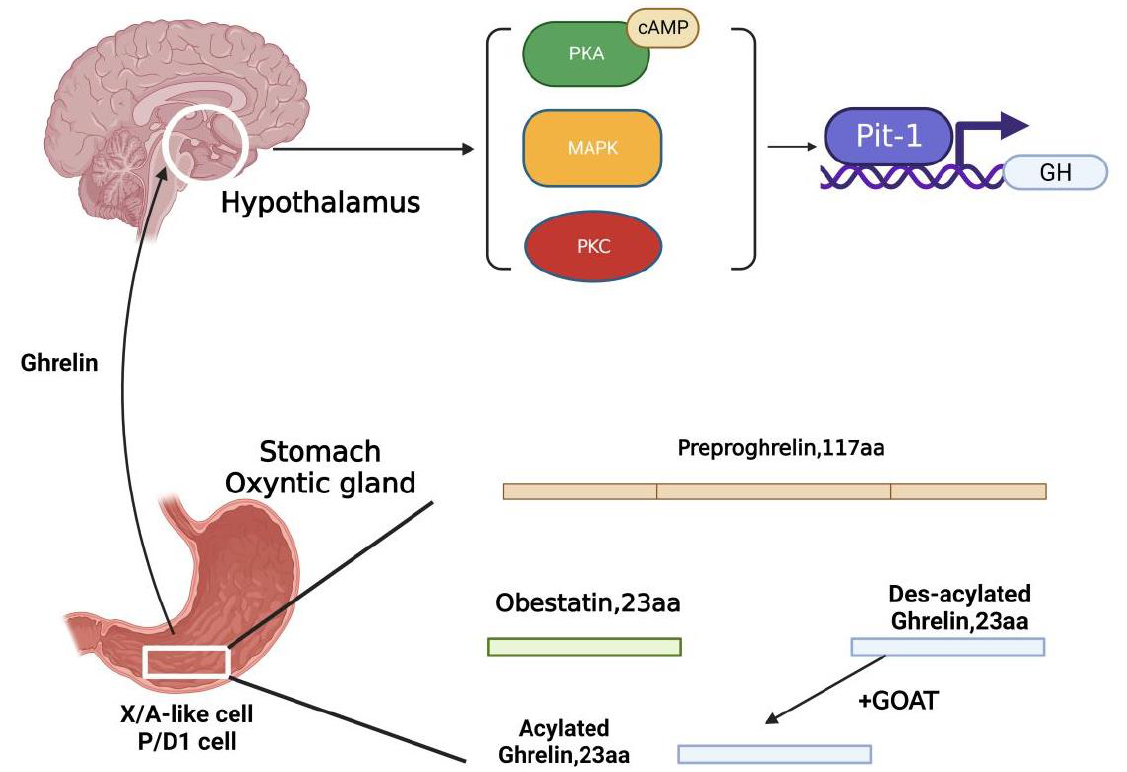
Figure 1. Ghrelin’s synthesis and actions through brain–gut transport. Ghrelin is synthesized from preproghrelin and transported through blood circulation to the hypothalamus, where it stimulates growth hormone secretion. PKA, protein kinase A; Camp, cyclic adenosine monophosphate; MAPK, mitogen-activated protein kinase; PKC, protein kinase C; GH, growth hormone; GOAT, ghrelin-o- acyltransferase. Created with BioRender.com.